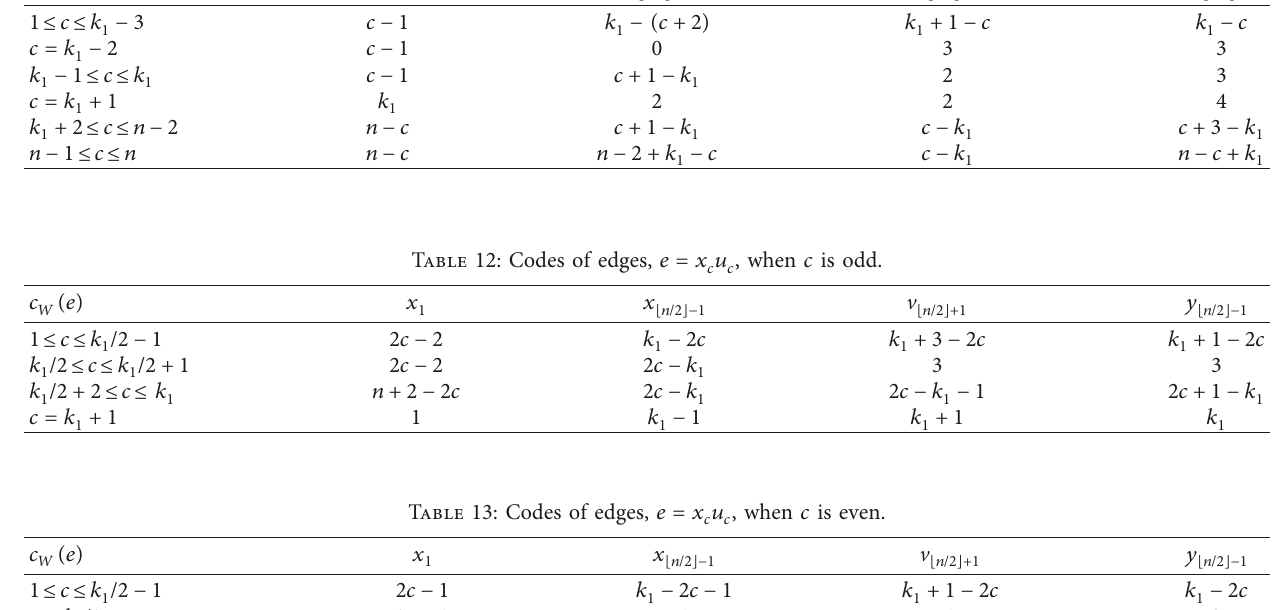
Table 11: Codes of outermost edges, e � x